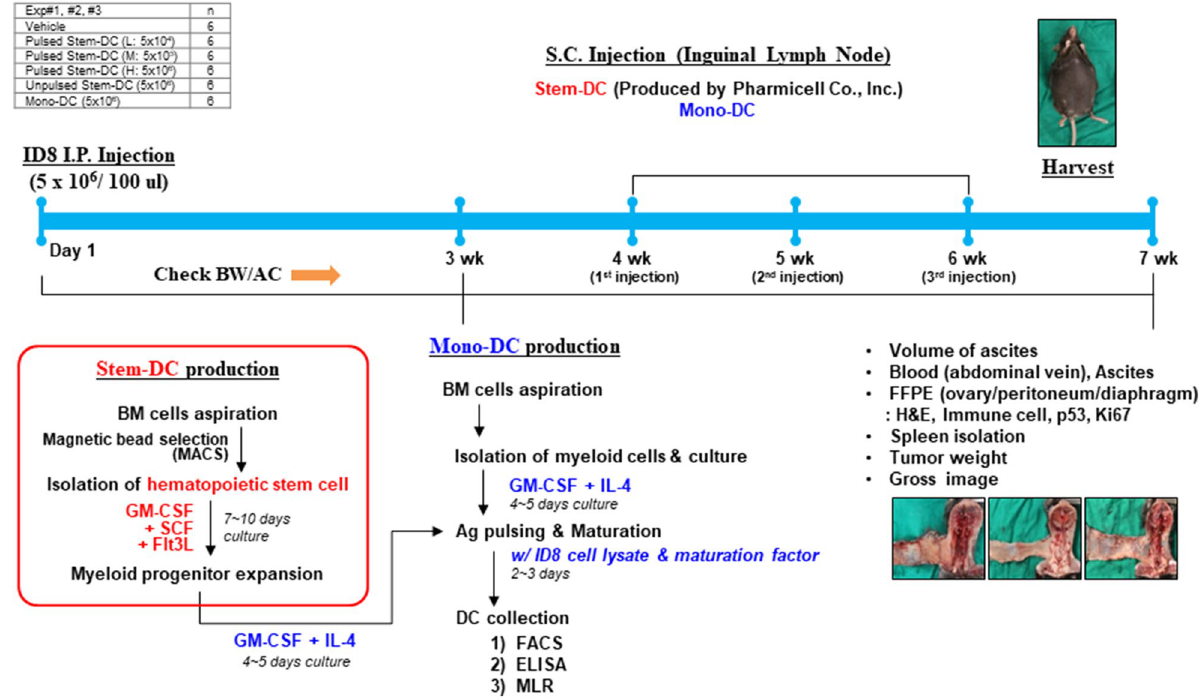
Figure 1. Workflow for the ovarian cancer orthotopic model using bone marrow-derived dendritic cells. We performed three independent experiments to evaluate the efficacy of mouse CD8α+ DCs originating from mouse BM stem cells, which correspond to human BDCA3+ (CD141+) DCs. An orthotopic model was established by intraperitoneally injecting ID8 mouse ovarian cancer cells. Six different treatments,